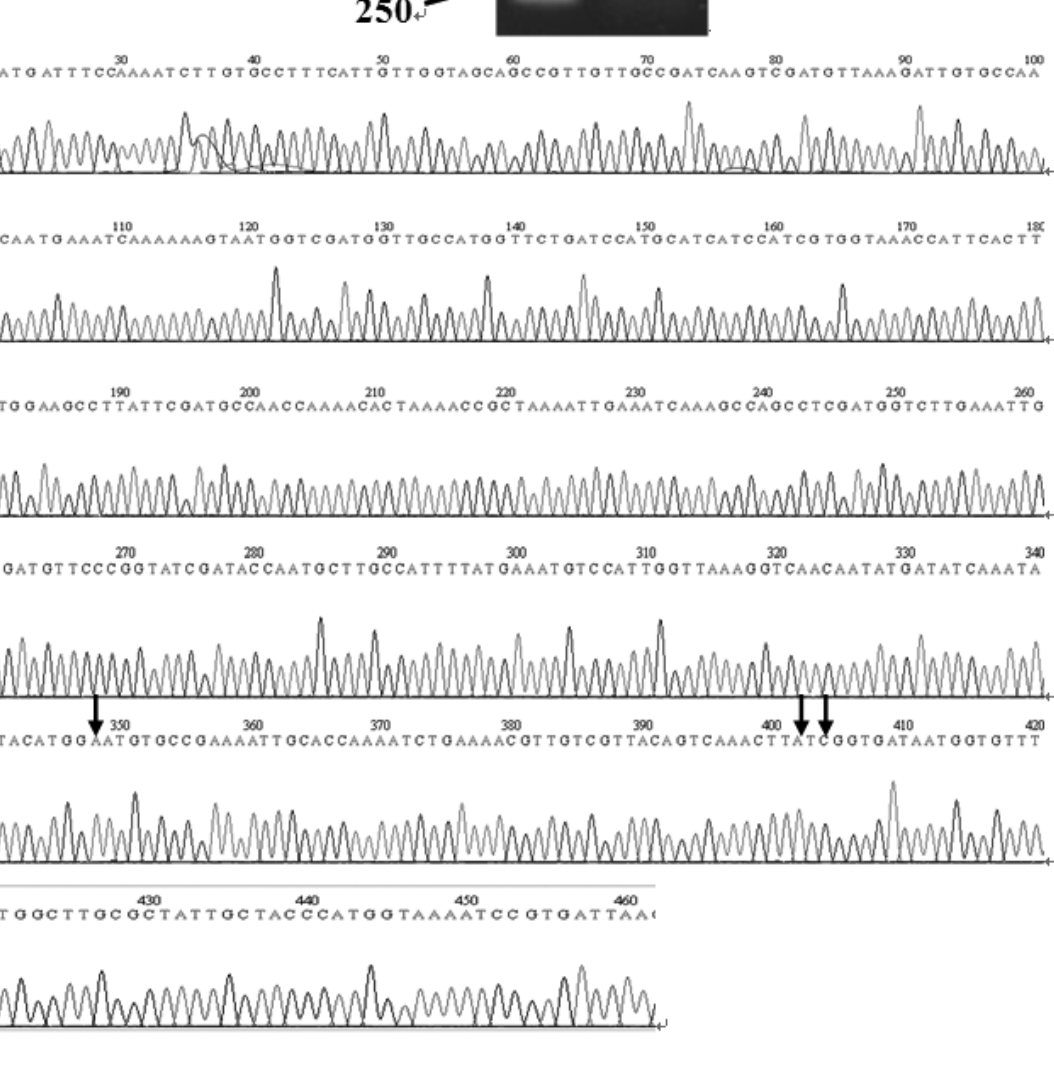
Fig. 1 – Cloning and sequencing of cDNA encoding Der f 2. ( A ) Amplification of the cDNA encoding for Der f 2 protein by RT-PCR. Total RNA was isolated from mites using RNA isolator and subjected to RT-PCR as described in “Materials and Methods”. The PCR products were separated on a 1% agarose gel containing ethidium bromide. Lane M , DNA Marker DL2, 000; Lane 1 , PCR product (441bp). ( B ) Sequencing results for the recombinant plasmid pMD19-T-Der f 2. Being compared with the reference sequence (GenBank AB195580 ), there are three mutations at positions 328 (G > A), 382 (G > A) and 384 (T > C), which were marked with an